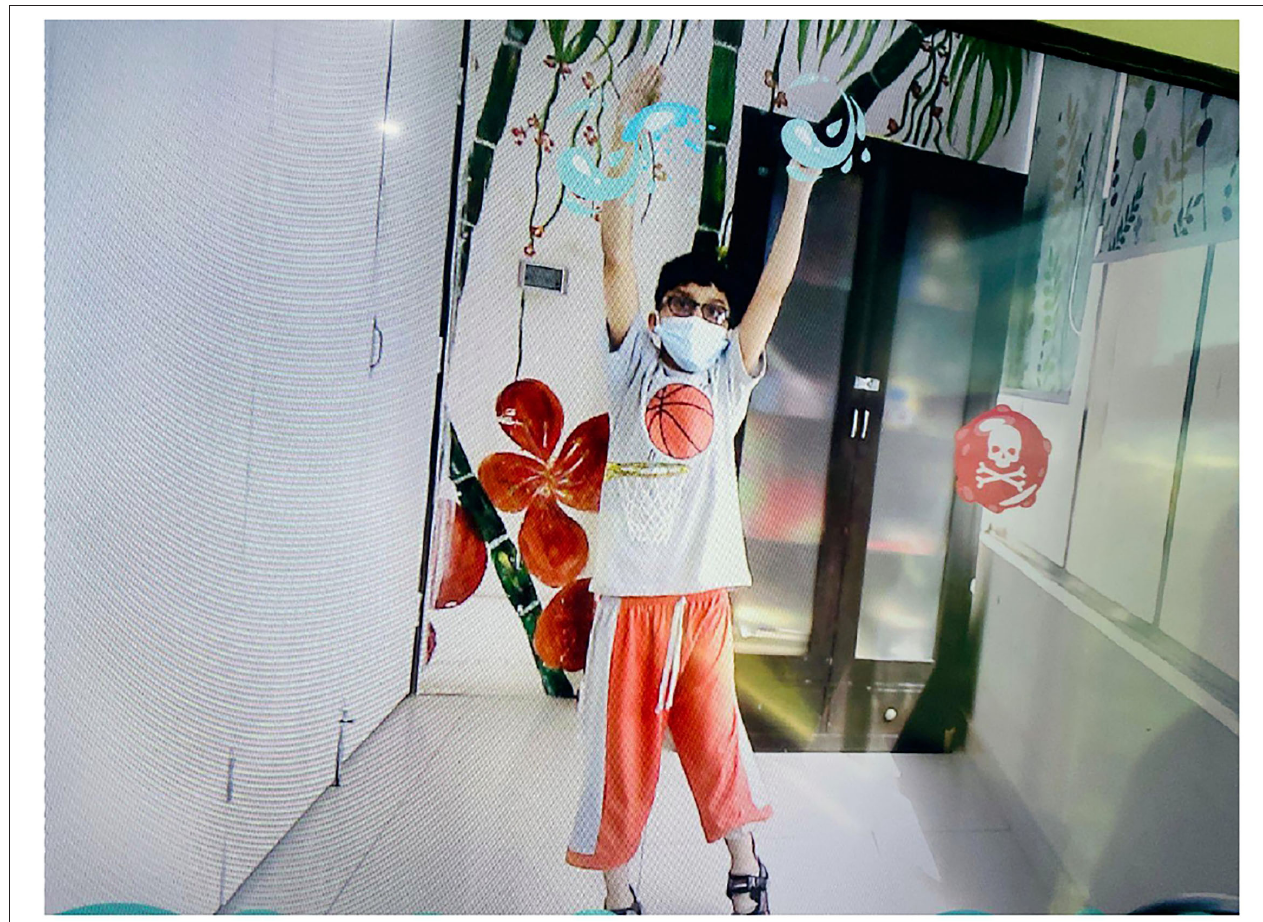
FIGURE 3 | Bubble Pop (AR